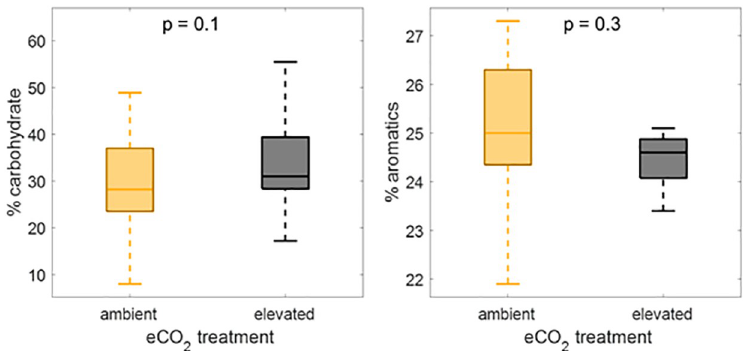
Fig 5. Effect of CO 2 treatment. Comparison of percent carbohydrate (panel A) and percent aromatics (panel B) in the ambient and elevated CO 2 treatments. Values for the boxplots were taken only from 2019, after the eCO 2 treatment had begun and only from surface peat ( < 50 cm) where the majority of root inputs occurs. Results of T-tests comparing elevated and ambient values are given in the top of each